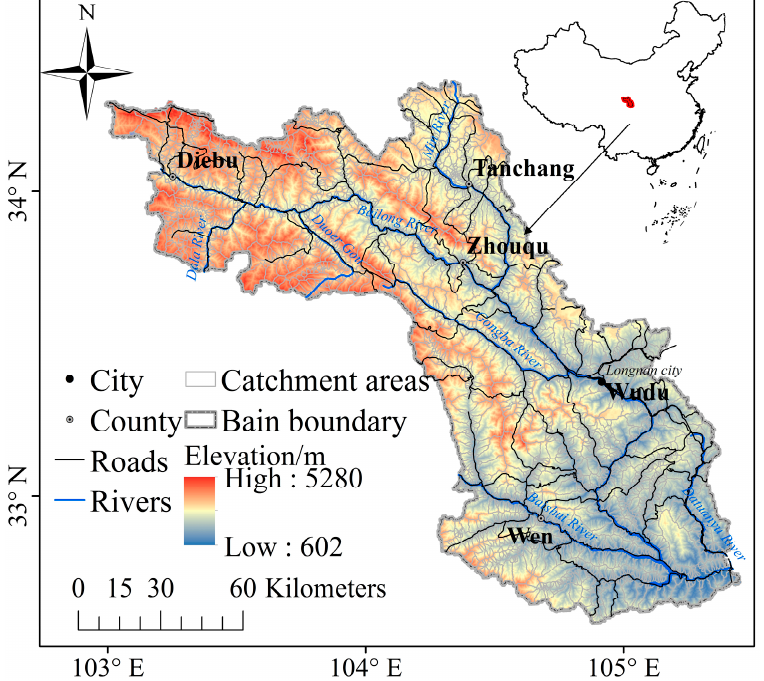
Figure 1. The location of Bailong River Basin and boundary extraction results of 1986 catchments.